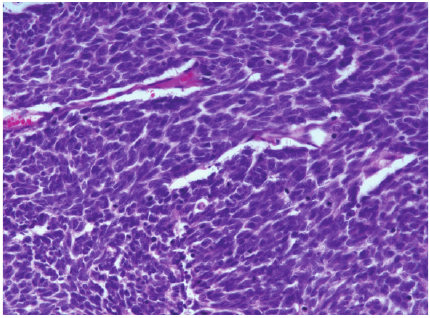
Figure 6: Histopathology of the adrenal gland mass showed similar findings observed in the axillary mass but had adopted more spindled cell morphology (HE ×